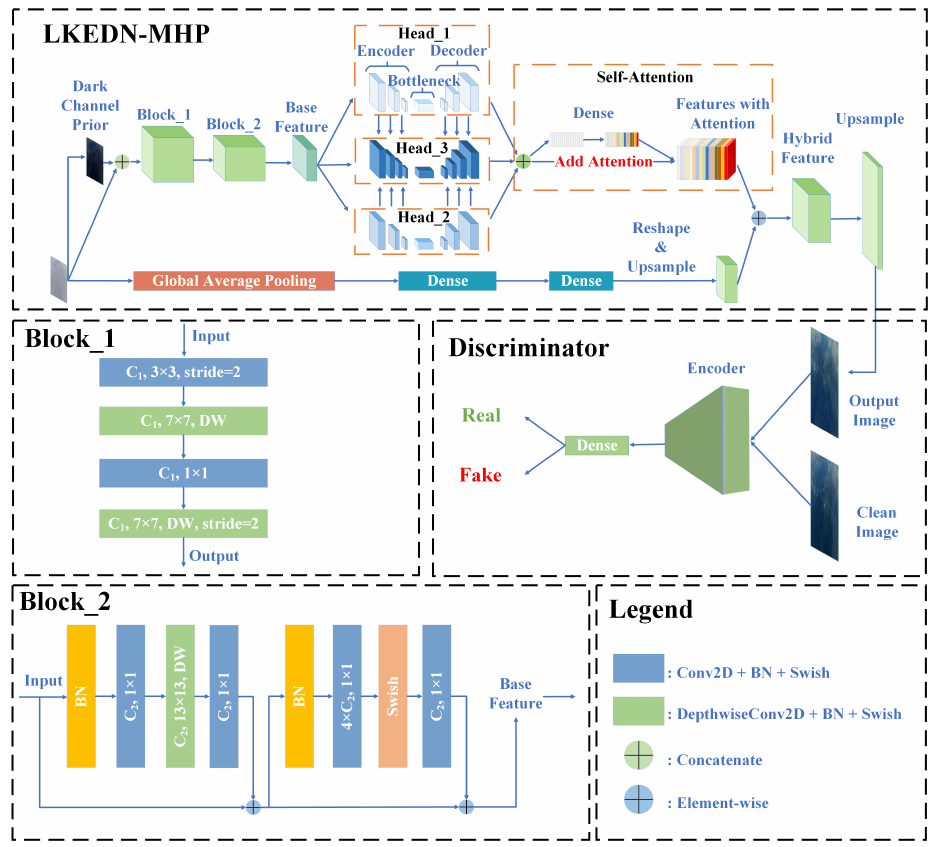
Figure 1. The architecture of the LKEDN-MHP. The guidance map is concatenated with the original input in the local path. The predictions of reflectance, shading, and semanteme are generated by the multihead pyramid. We use self-attention to mark notable information and then merge the local and global features. The generated haze-free image and the GT are the input of the